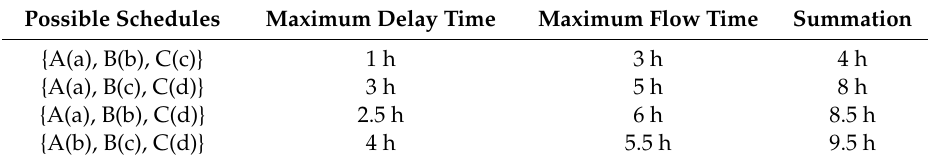
Table 4. Example results obtained in the second step of the proposed scheduling algorithm.